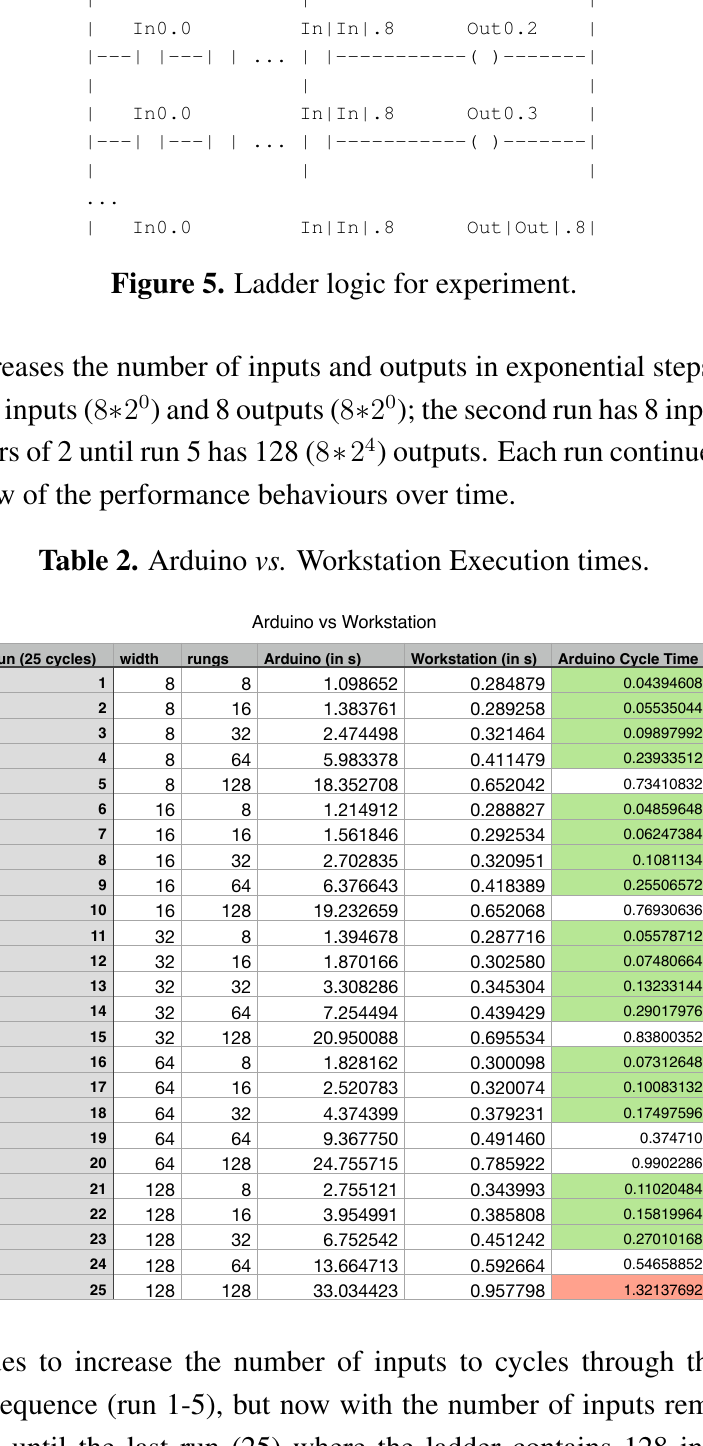
Figure 4. Comparison of execution times